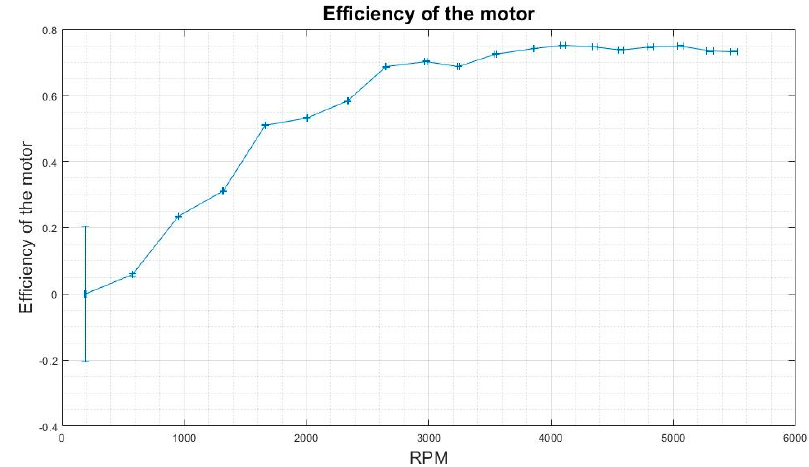
Figure 9. E ffi ciency of the Figure 9. Efficiency of the motor. Figure 9. Efficiency of the motor.